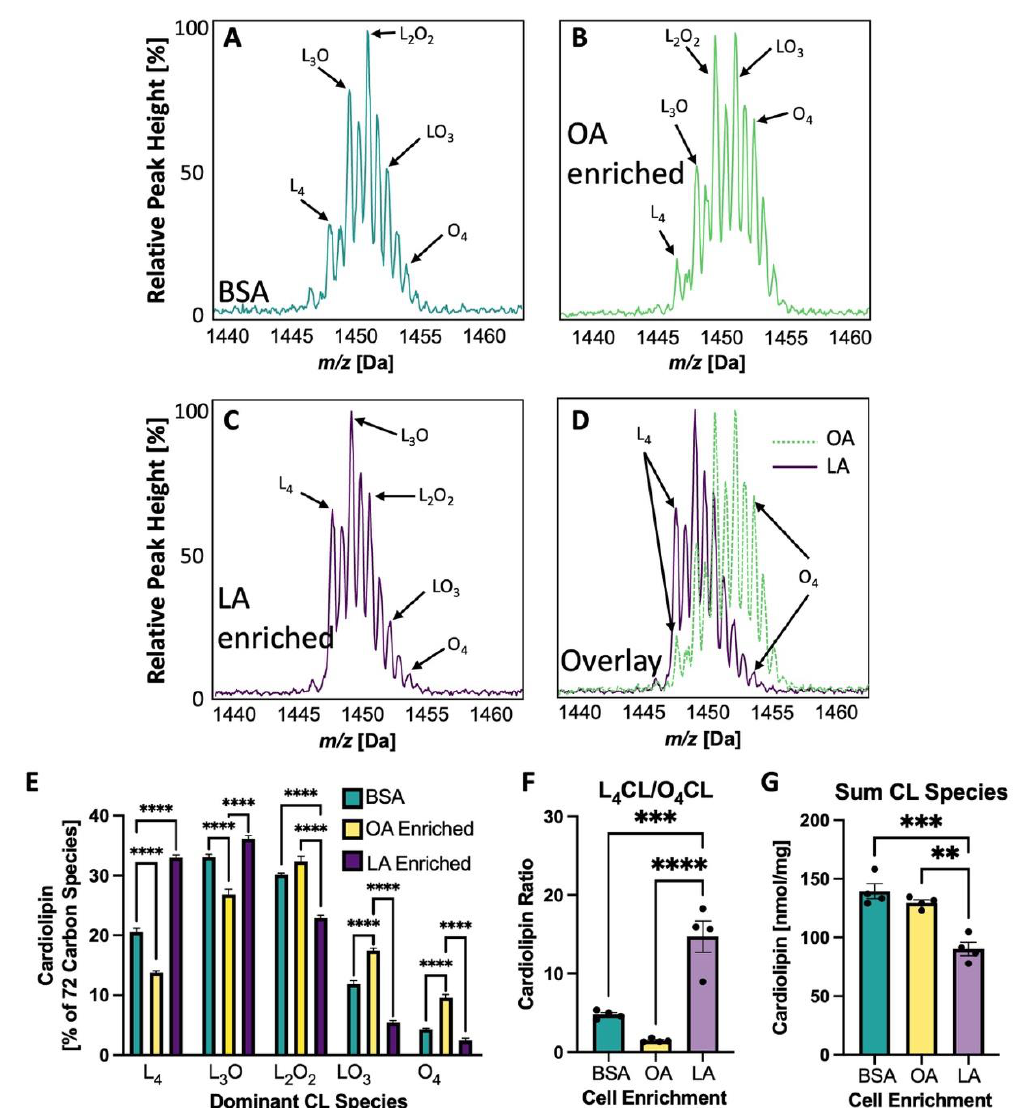
Figure 5. CL Spectral Shift with LA or OA Enrichment. ( A – D ) CL spectra showing only 72 carbon peaks having five predominant CL species with variable numbers of linoleate(L;LA) or oleate(O;OA) side chains. ( A ) Neonatal rat ventricular myocytes (NRVMs) treated with bovine serum albumin (BSA) alone, ( B ) NRVM CL enriched with OA, ( C ) NRVM CL enriched with LA, ( D ) overlay of ( B , C ). ( E ) The percentage of each of the five 72 carbon CL species with these treatments. ( F ) The L 4 CL to O 4 CL ratio for each treatment. ( G ) The sum of 14 detectable CL species. ** p < 0.01, *** p < 0.001; **** p < 0.0001, N = 4 in ( E ) through ( G ). Error bars represent standard error of the mean.